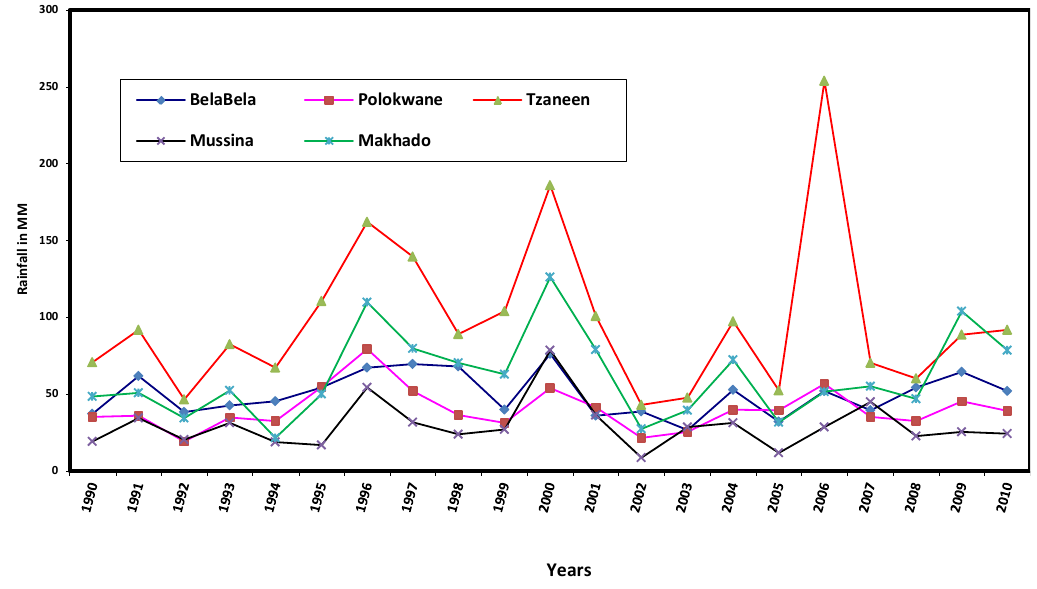
Figure 3. Rainfall trends 1990 to